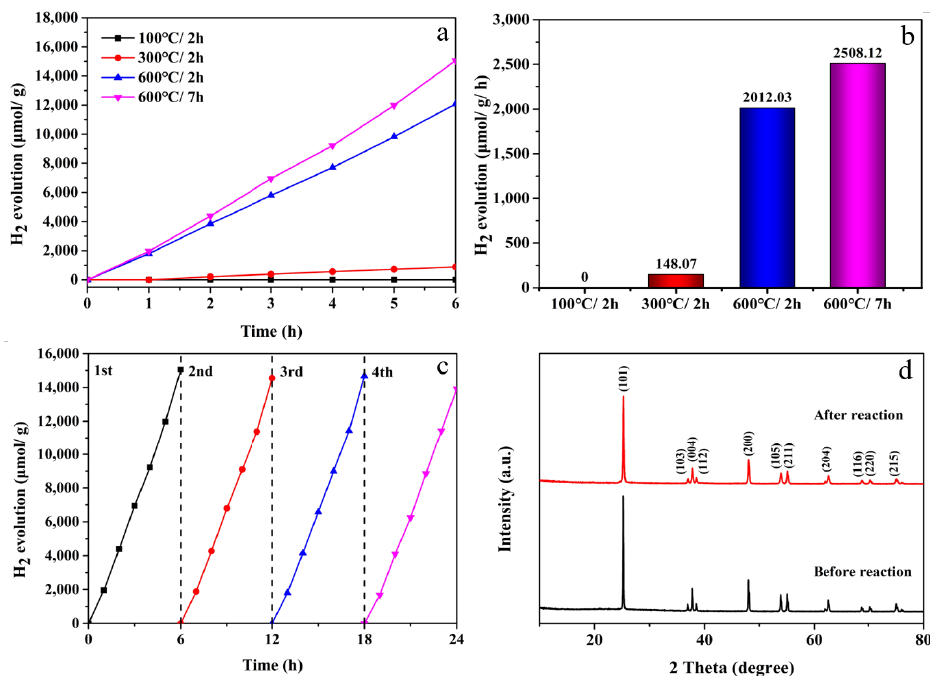
Figure 10. ( a ) Photocatalytic H 2 yield, ( b ) H 2 evolution rate, ( c ) cycling test of photocatalytic H 2 generation of TiO 2 with annealing at 600 °C for 7 h and ( d ) XRD patterns of original and recycling samples of recycling samples. Note: 100 °C/2 h, the precursor calcined at 100 °C for 2 h; 300 °C/2 h, the precursor calcined at 300 °C for 2 h; 600 °C/2 h, the precursor calcined 600 °C for 2 h; 600 °C/7 h, the precursor calcined 600 °C for 7 h.